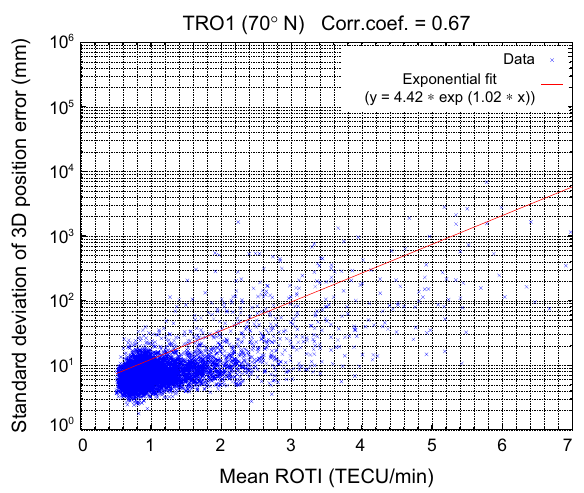
Fig. 2. Scatter plot of mean ROTI vs. 3D position error. The red line shows an exponential fit to the data. Table 3. Correlation coefficients and fit parameters. Corr.